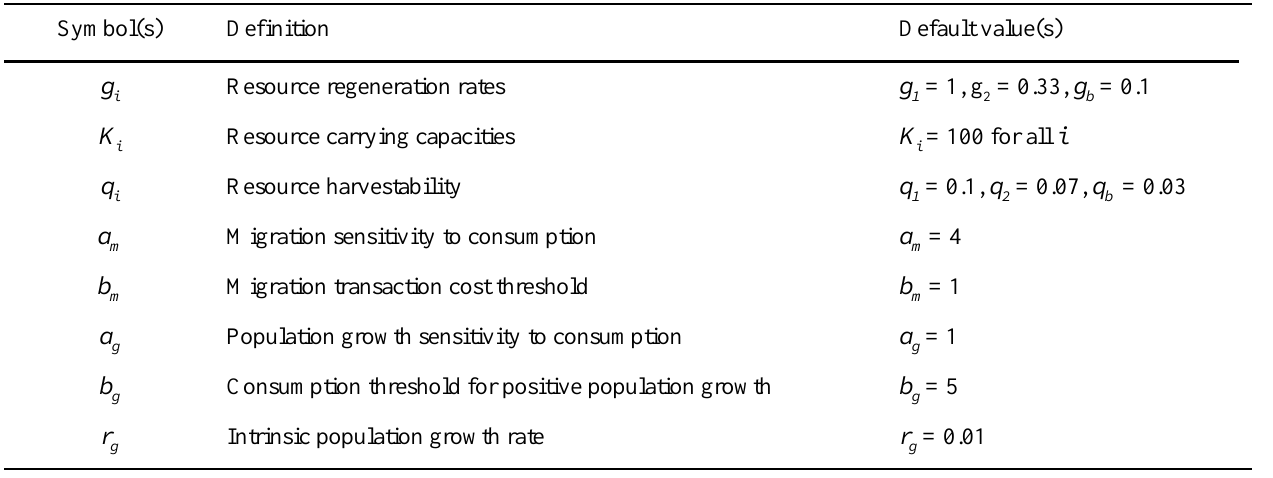
Table 1 . Parameter definitions and default